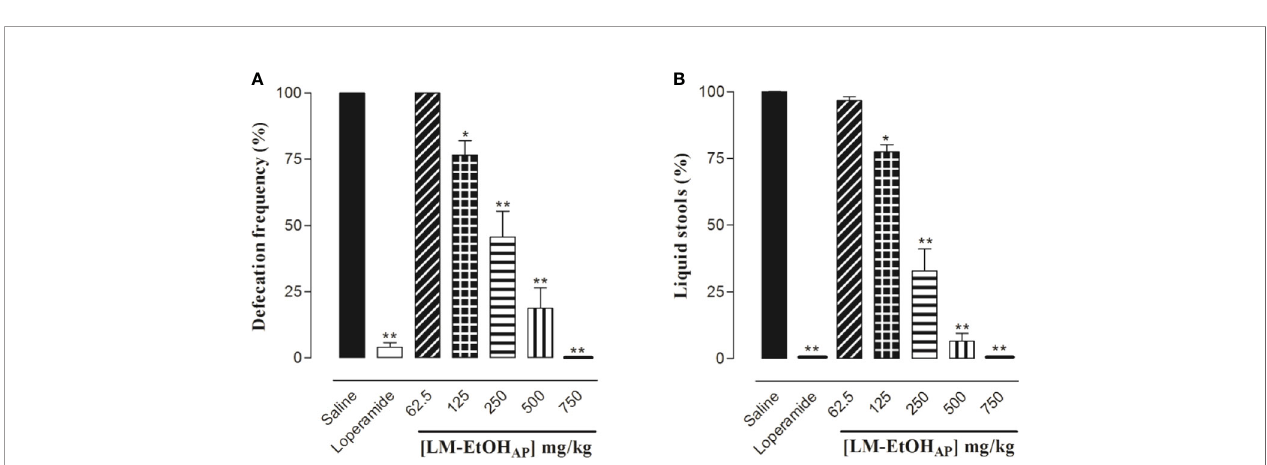
FIGURE 3 | Antidiarrheal effect of LM-EtOH AP on castor oil-induced diarrhea in mice. Percentage of total stool numbers (A) and percentage of liquid stools (B) . Columns and vertical bars represent the mean and S.E.M., respectively (n = 6). One-way ANOVA followed by Bonferroni ’ s post – test, * p < 0.05; ** p < 0.01 (saline vs. loperamide/LM-EtOH AP